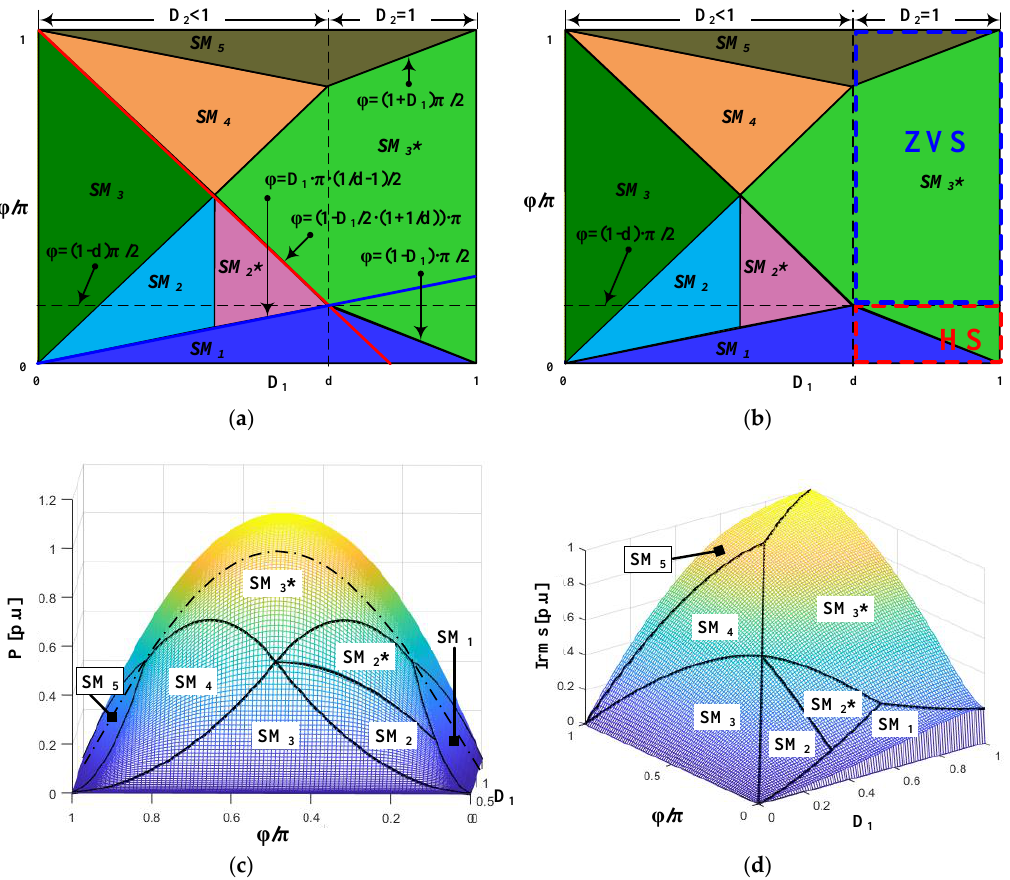
Figure 10. Case II for Extended Switching Modes (SM 1 , SM 3 *, SM 5 ), d = 0.677. ( a ) Depending and